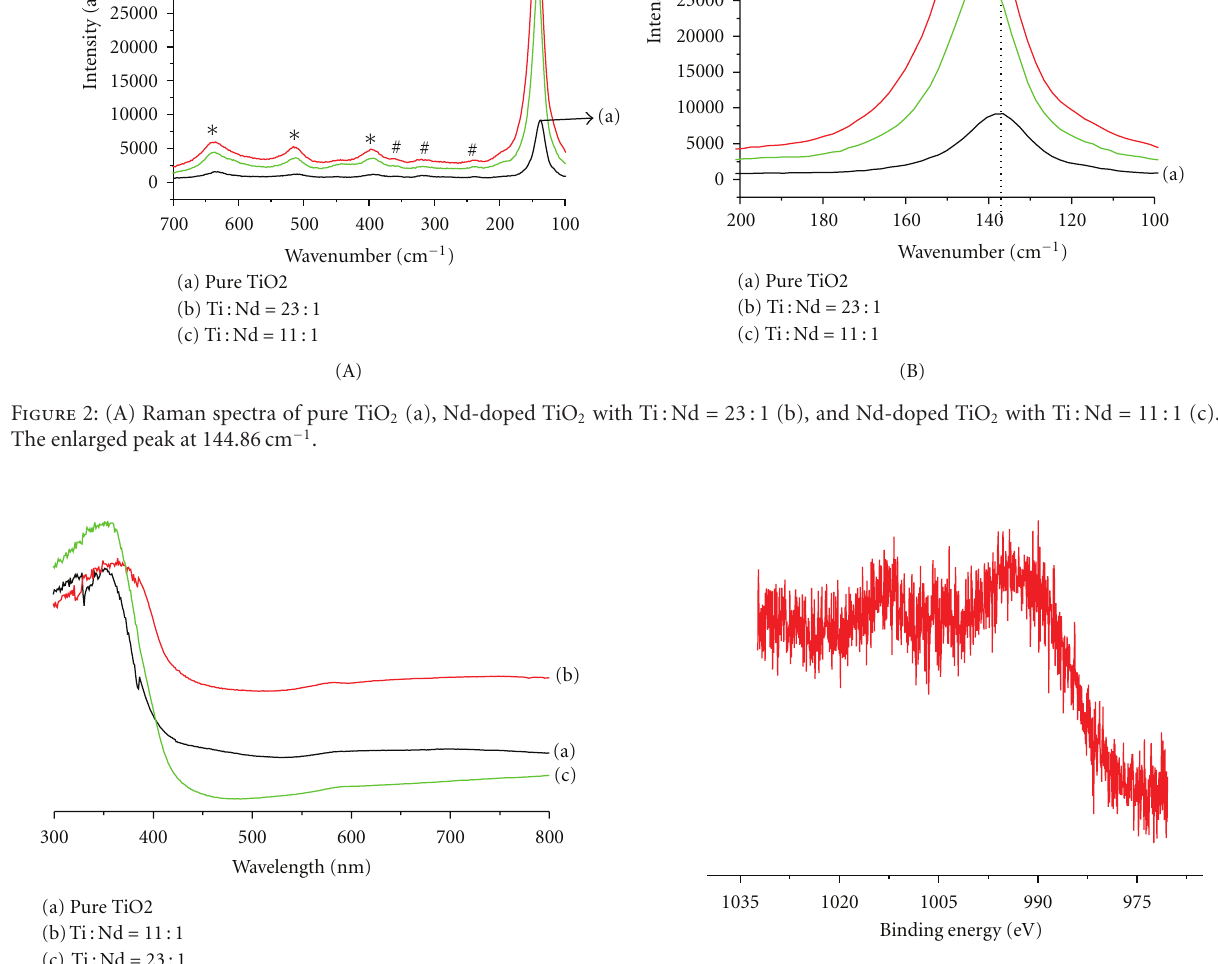
Figure 4: High-resolution XPS spectrum of Nd 3d for Nd-doped TiO 2 with Ti: Nd = 11